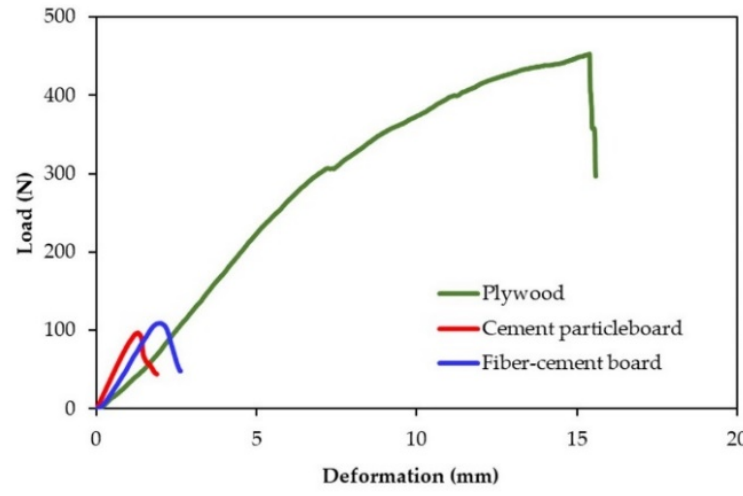
Figure 6. Representative load-deflection curves from the three-point bending test of the surface materials.